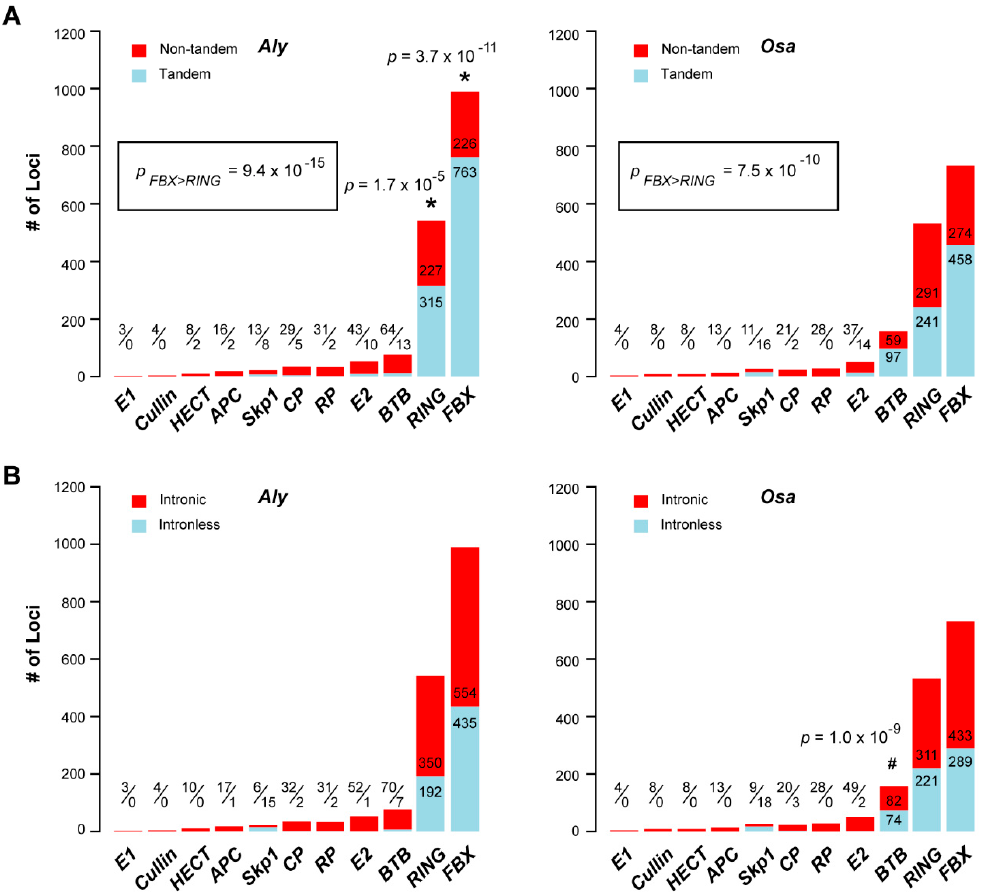
Figure 6. Comparison of the role of recent duplications in expanding the sizes of 11 UPS gene families in Aly and Osa . ( A ) Tandem duplication plays a more significant role on the expansion of the FBX and RING gene families in Aly than in Osa , and vice versa for the BTB family. In both genomes, more FBX genes were tandemly duplicated than RING members. The sizes of tandem and non-tandem loci are indicated either in the denominator and numerator of a fraction, respectively, or directly on the bar plot. ( B ) Significantly more intronless BTB loci were found in Osa than in Aly but not others. The sizes of intronless and intronic loci are indicated either in the denominator and numerator of a fraction, respectively, or directly in the bar plot. Single asterisks indicate a significant enrichment of tandem duplications in Aly . Hash symbols denote a significant enrichment of tandem duplications or intronless genes in Osa . Inset shows the enrichment comparison of tandem duplications between the FBX and the RING families in Aly and Osa genomes. Statistical significance was performed based on Fisher’s exact test and the p values are indicated.